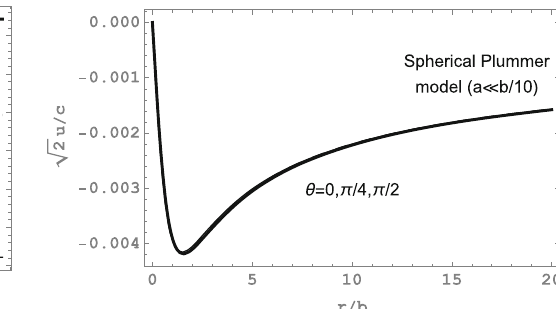
tion velocity profile hardly varies with the polar angle θ , corresponding to a nearly constant tangential velocity on a sphere. Note that the radial distance to the axis of rotation is R = r sin θ